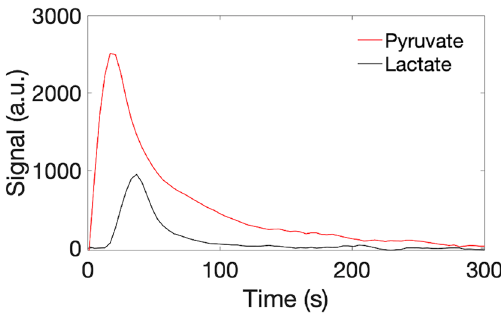
Figure 2. Example simulated metabolic curves for intracellular pyruvate (red) and lactate (black). T 1 Pyruvate,